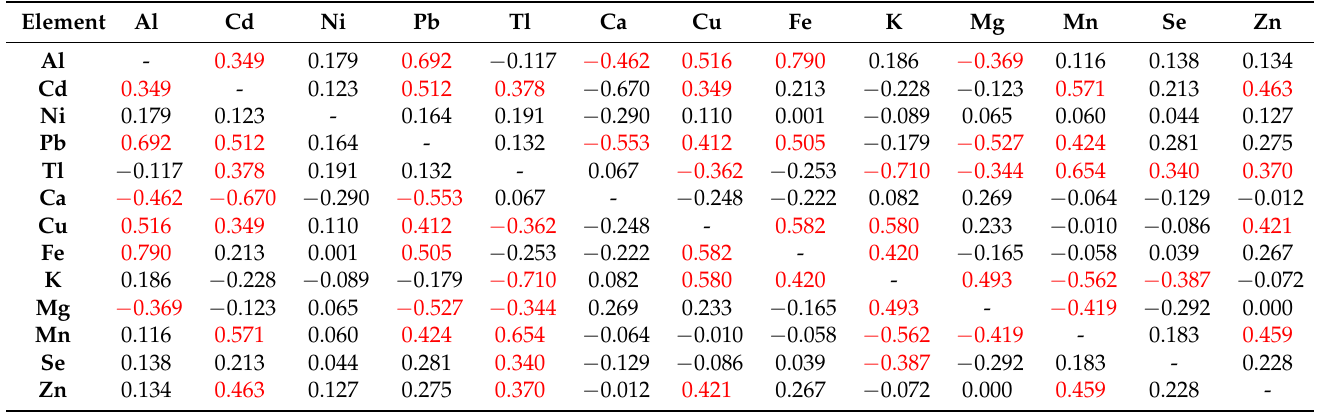
Table 2. Spearman’s rank-order correlations calculated between individual elements’ concentrations in plants.